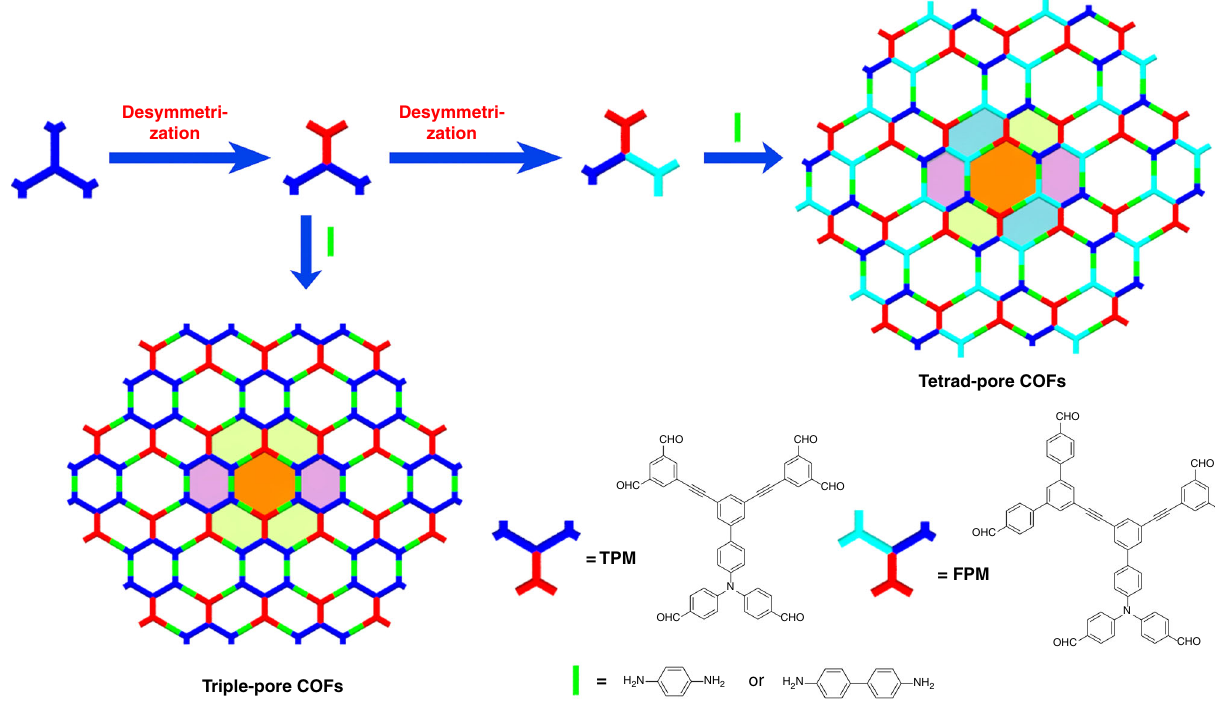
Fig. 1 Design strategy. Cartoon representation of the fabrication of triple-pore and tetrad-pore